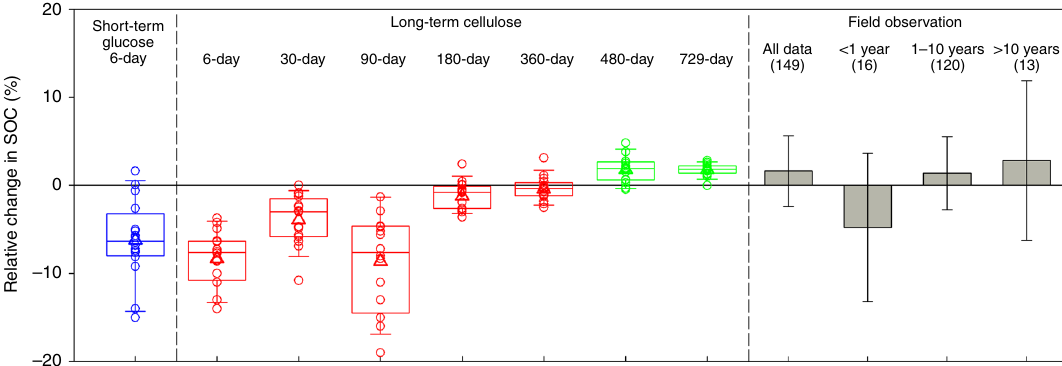
Fig. 2 Modeled and observed soil organic carbon changes under warming. Modeled relative change (%) in soil organic carbon (SOC) based on a fi ve- decade projection under 5 °C warming using parameters obtained from calculations using dataset of short-term glucose (6 day, blue), cellulose <1 year (6, 30, 90, 180, 360 days, red) and cellulose equal to or more than 1.5 years (480 and 729 days, green). Observations are based on the meta-analysis conducted in all fi eld-warming experiments (all data, gray) and those over different experimental durations (e.g., <1 year, 1 – 10 years, and >10 years). In model results, boxplots show means (triangle), medians (line), 1st and 3rd quartiles (box, interquartile range or IQR), upper and lower extremes (whiskers). The whiskers were determined as ≤ 1.5 times IQR against 1st and 3rd quartiles, respectively. In model results, N = 16 independent runs in each box plot; In the meta-analysis, the number of observations is in